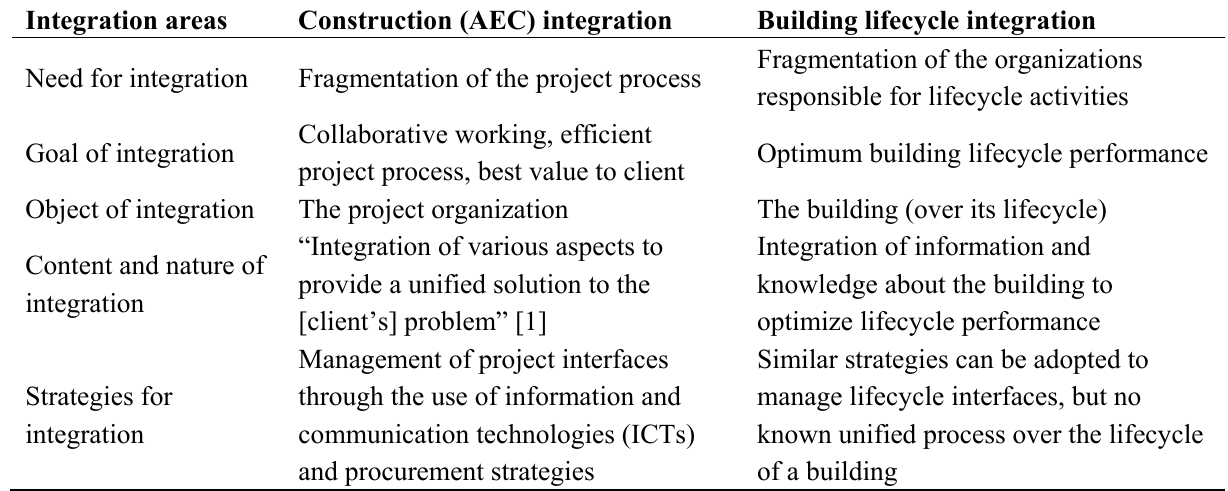
Table 1. Comparison between Construction and Building Lifecycle